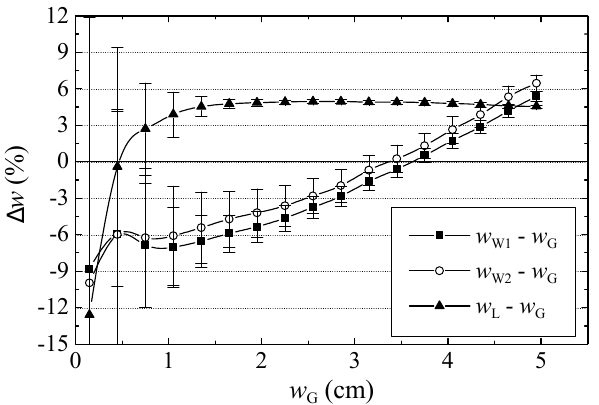
Fig. 1. Average relative differences of precipitable water estimated by Wright’s (using two different algorithms to calculate T d , w W1 and w W2 ), Leckner’s (w L ) and Gueymard’s (w G ) methods against precipitable water estimated by Gueymard’s